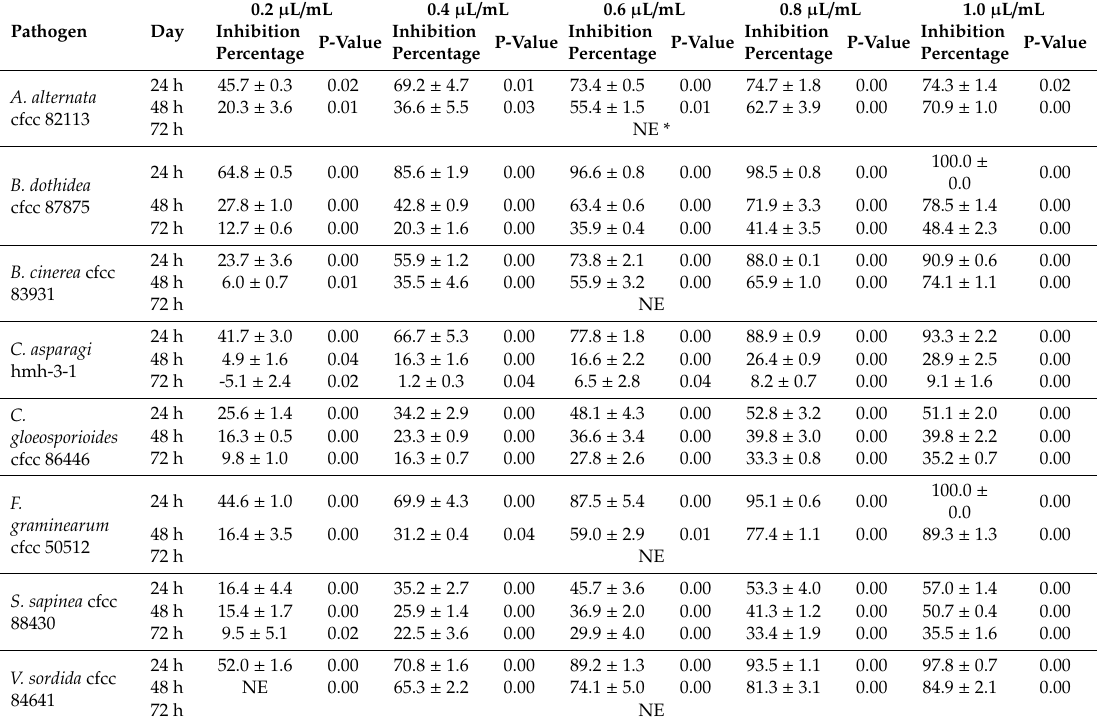
Table 3. E ff ects of α -terpinene on fungal pathogens of plants determined by two-compartment Petri plate bioassay